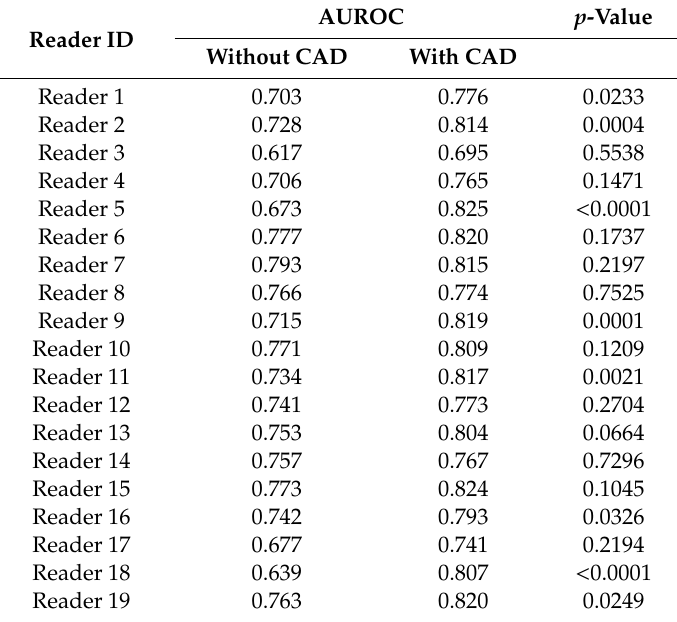
Table 2. Reader performance. Area under the ROC curve (AUC) for individual readers without and with